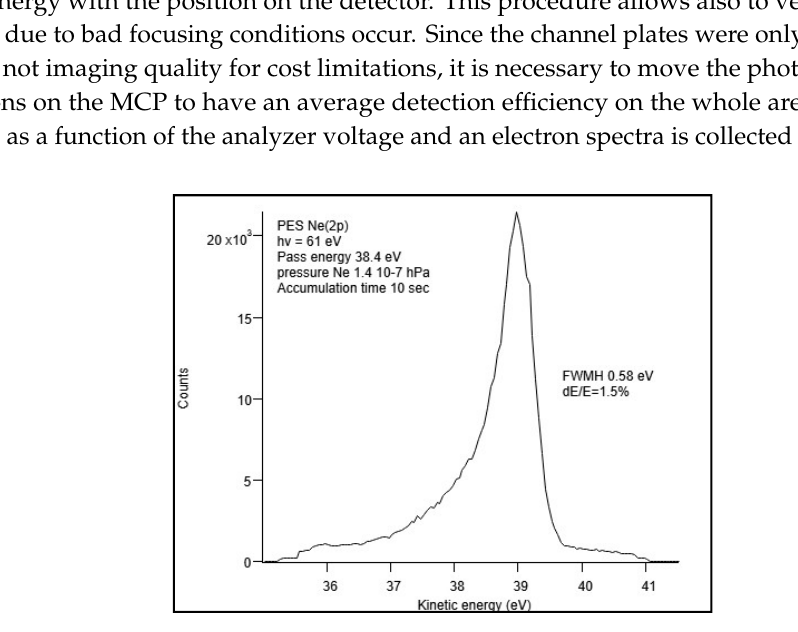
Figure 4. Ne 2p photoelectron peak. The resolution Δ E/E is 1.5% thanks to the 1 mm precision encoding with the delay line. The peak asymmetry towards lower energy can be explained by the focusing at lower z of electrons created out of the central zone seen in Figure 2b.